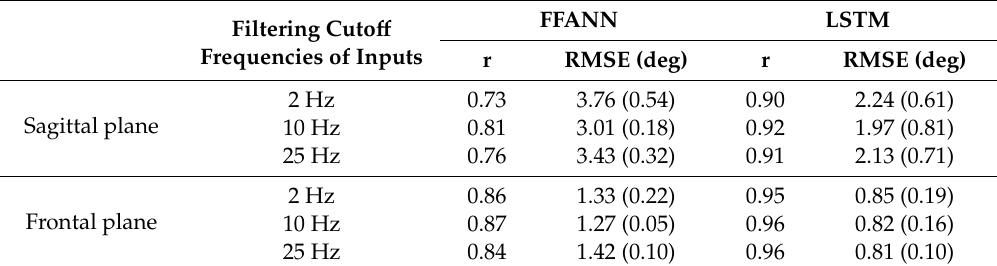
Figure 5. COM-COP inclination angle (IA) calculated using the 3D motion analysis system and predicted using the proposed neural network models. Table 1. Coefficient of correlation and root-mean-square error (RMSE) values between COM-COP IA calculated using a 3D motion analysis system and predicted using neural network models. FFAN: feed-forward ANN; LSTM: long-short term model.